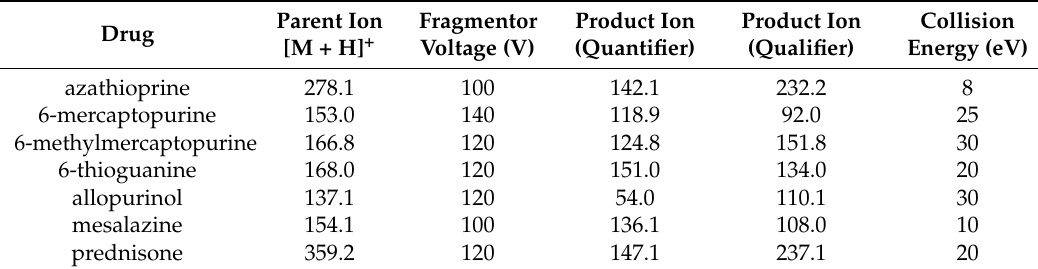
Table 1. Parent–product ion